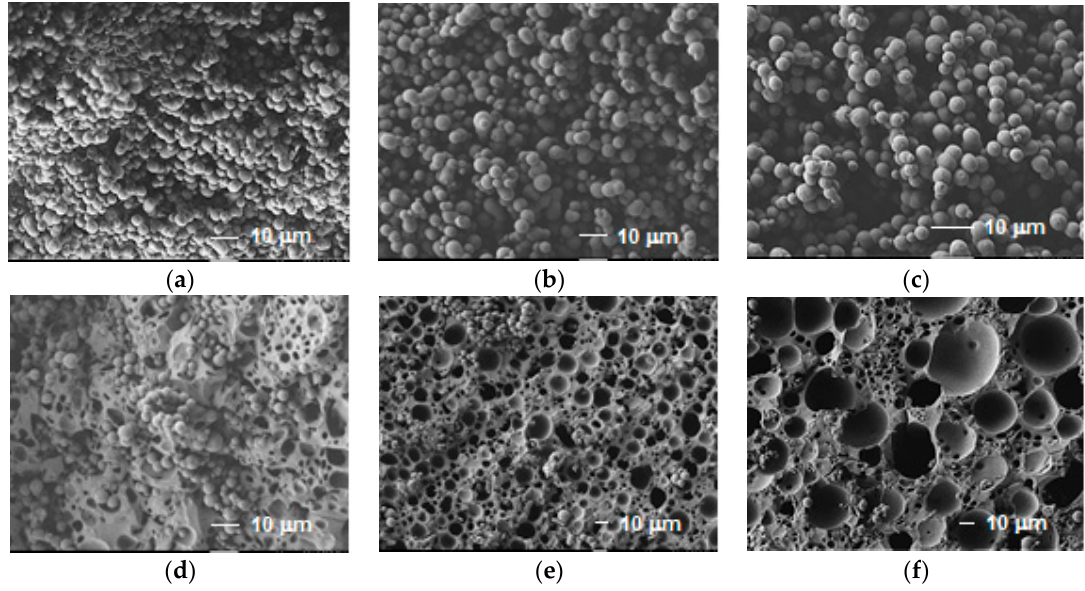
Figure 2. SEM images of AM4-HDA porous polymers Case I (feed molar ratio of AM4/HDA: 1/2), monomer concentration and temperature ( a ) I-20w-70d, ( b ) I-20w-80d, ( c ) I-20w-90d, ( d ) I-25w-80d, ( e ) I-25w-90d, and ( f ) I-30w-90d.